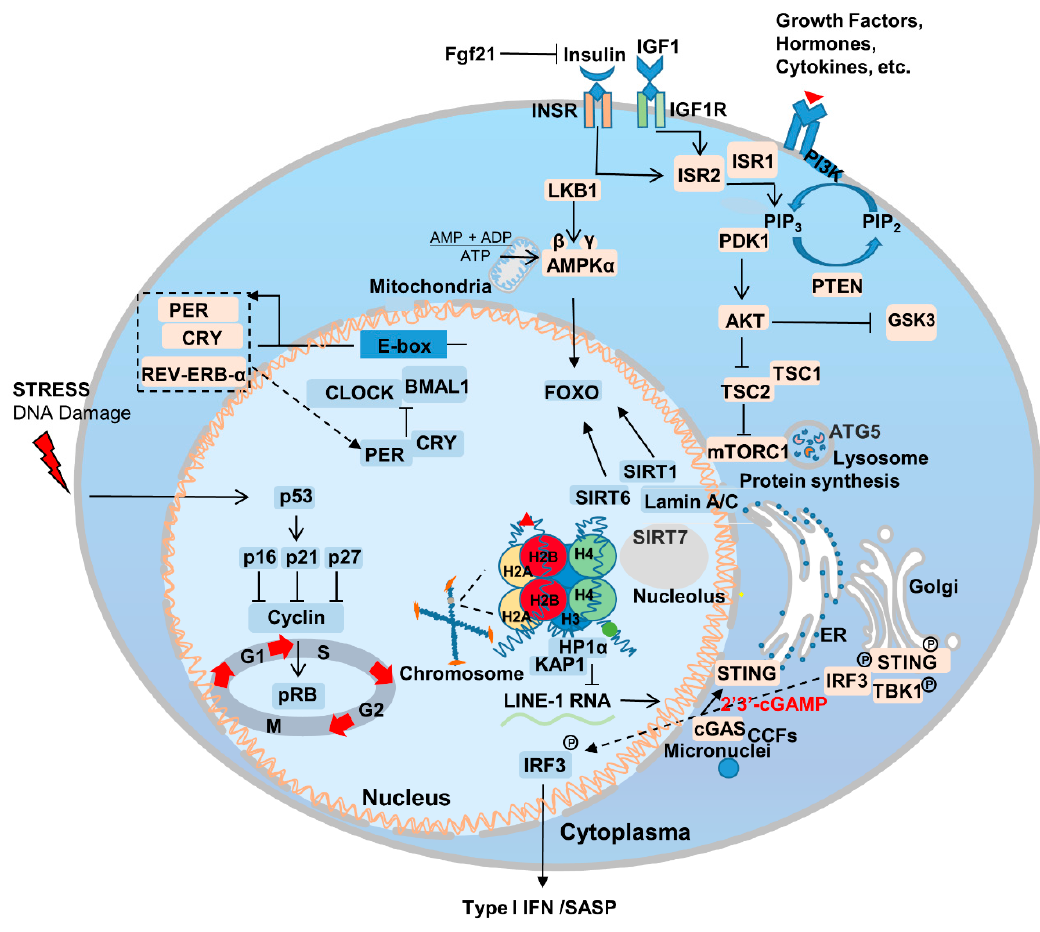
Figure 1. Genetic and signaling mechanisms underlying aging. Aging involves multiple genetic alterations in a range of pathways, including, but not limited to, nutrient sensing, sirtuins, nuclear skeleton proteins, immunity, inflammation and circadian rhythm. PI3K/AKT, AMPK, and mTORC1 serve as the core members of lipid, glucose, and amino acid sensing. Lamin A/C interacts with SIRT1, 6 and 7 to regulate chromatin and intracellular homeostasis. cGAS-STING responds to internal and external nuclear pressures and regulates senescence-associated secretory phenotype (SASP). The feedback regulation of circadian rhythm-associated genes is also affected by other aging-related genes. p16, cyclin-dependent kinase inhibitor 2A; p21, cyclin-dependent kinase inhibitor 1A; p27, cyclin-dependent kinase inhibitor 1B; Rb, retinoblastoma protein.